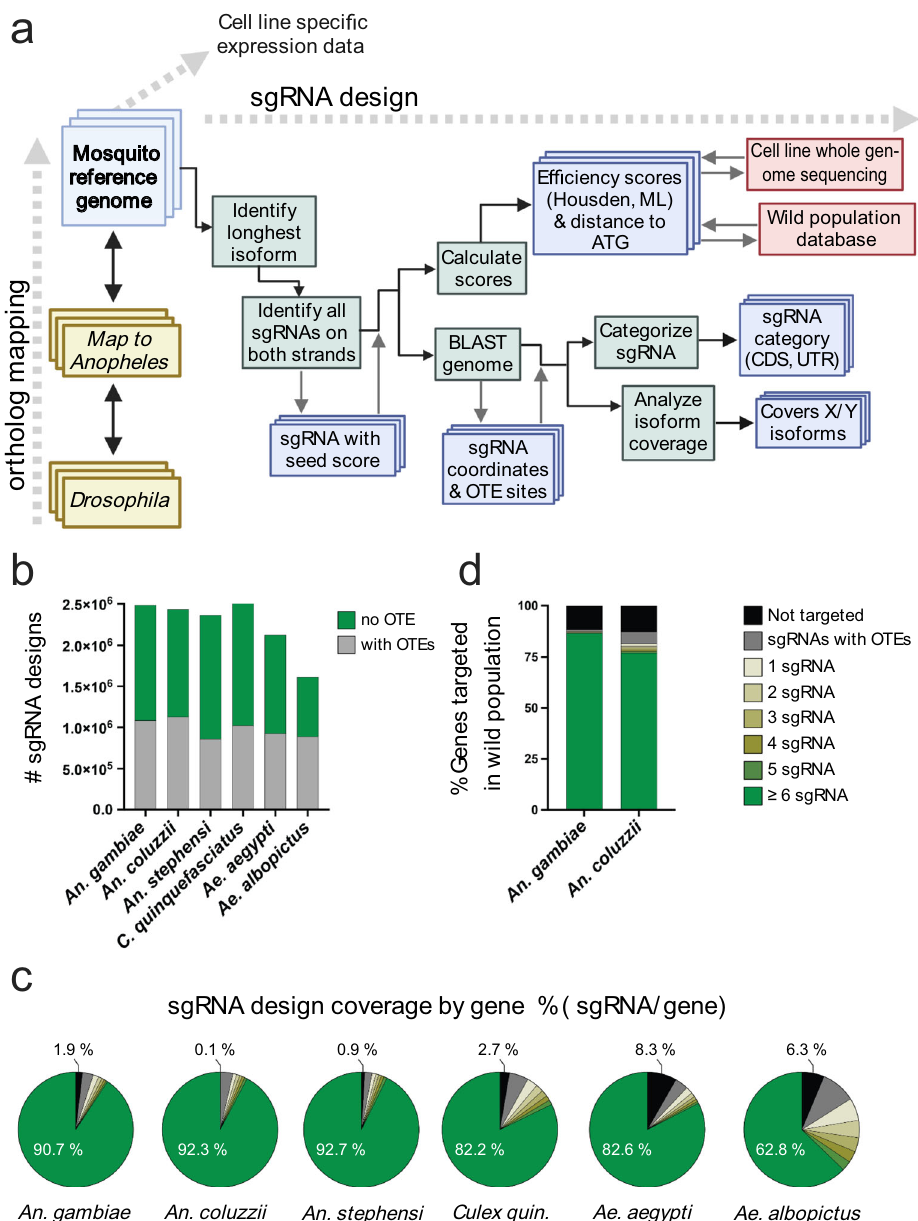
Fig. 1 CRISPR GuideXpress: an online bioinformatics framework for CRISPR sgRNA design and analysis. a Features and sgRNA design work fl ow. Ortholog mapping, cell line-speci fi c expression data, and sgRNA design for six supported mosquito species are integrated at one interface. Genes can be searched individually or in batch mode. Direct ortholog searching is available between An. gambiae and other mosquito species or Drosophila . After a gene name or ID is entered, the tool retrieves corresponding transcripts and displays precomputed sgRNAs and associated scores. The sgRNAs are computed as follows. The longest isoforms are identi fi ed from transcripts. Next, all possible PAMs and associated sgRNA designs on both strands are selected. Each design is then assigned a seed score based on uniqueness of the 12-15 nt 3' sequence (excluding the PAM). For each guide, a BLAST search is used to de fi ne speci fi city (off-target score). Each guide is mapped to the genome and categorized based on the gene region targeted and the respective isoform coverage. All sgRNA designs are evaluated to yield multiple ef fi ciency parameters: ‘ Housden ’ score, machine learning (ML) score, and distance from ATG. Additionally, sgRNA designs for An. gambiae and An. coluzzii are assigned a ‘ wild population ’ ef fi ciency score calculated from the Ag1000 Genome project dataset (see methods). To optimize for use in An. coluzzii Sua-5B cells, the tool indicates if the sgRNA sequences fully match the Sua-5B whole-genome sequence. ( b – d ) Analysis of genome-wide CRISPR KO sgRNA designs targeting protein-coding genes in supported mosquito species. b Histogram representing total number of sgRNA designs in two categories: (green squares) “ no OTE ” (off-target effect), with minimal off-target effects, or (gray squares) “ with OTE ” within the criteria (see Methods). c Genome-wide sgRNA design coverage, showing the percentage of genes targetable by sgRNAs with minimal OTE (light yellow to green), targetable only by sgRNAs with potential OTE (gray), or untargetable (black). d Genome-wide sgRNA design coverage by gene (%) in wild populations sampled in the Ag1000 Genome project. % of genes targeted and ranking based on # of sgRNAs/gene, as speci fi ed above. For this analysis were considered only sgRNA designs matching ≥ 95% of the wild genome sequences sampled. Source data are provided as a Source Data fi le. Raw statistics can be found in Supplementary Data